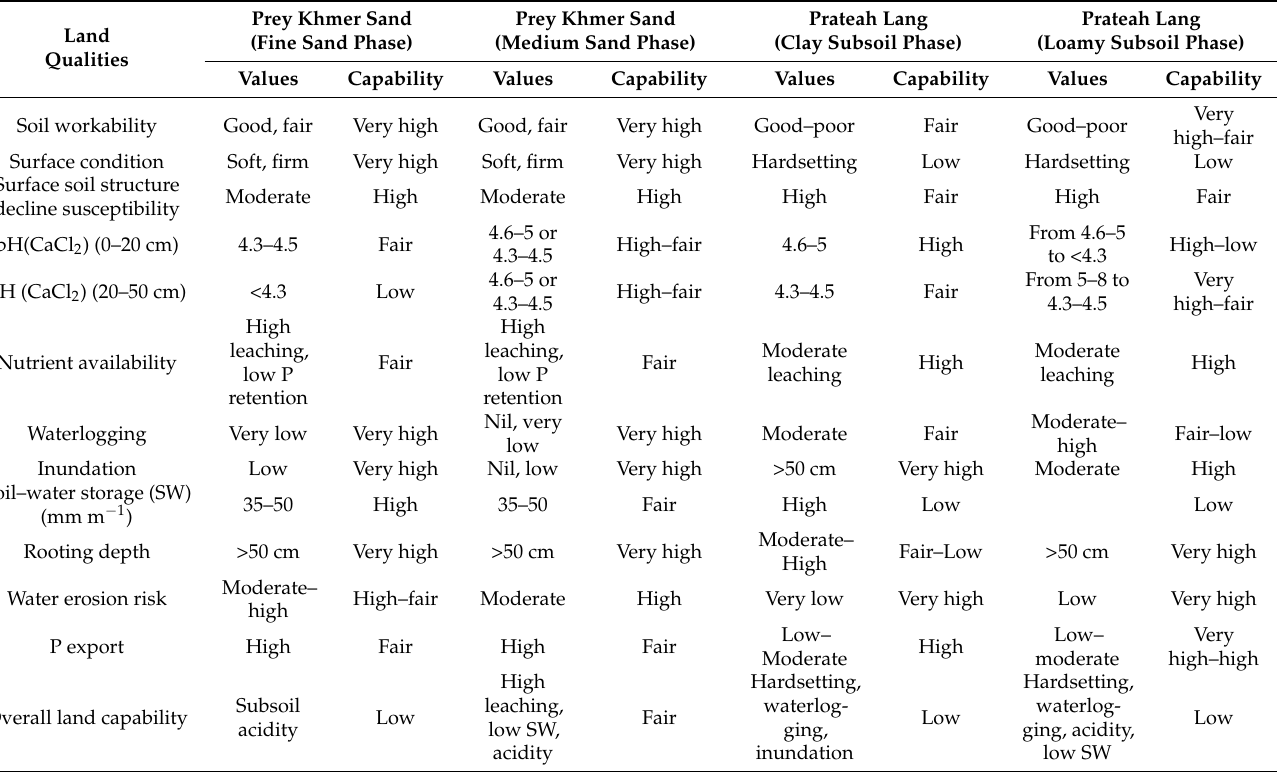
Table 8. Land capability ratings for upland cropping based on typical land quality values for the sandy soils of the Tramkak District in Takeo Province, Cambodia. The overall land capability rating is based on the rating of the most limiting land quality [3]. Note: The land capability ratings vary depending on individual crop requirements. The land quality values are averages for soil groups, and actual values may vary considerably at a given site.